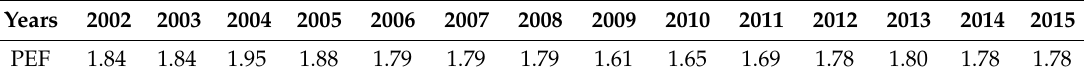
Table 2. Primary energy factor (PEF) for Sweden over the period from 2002 to 2015.